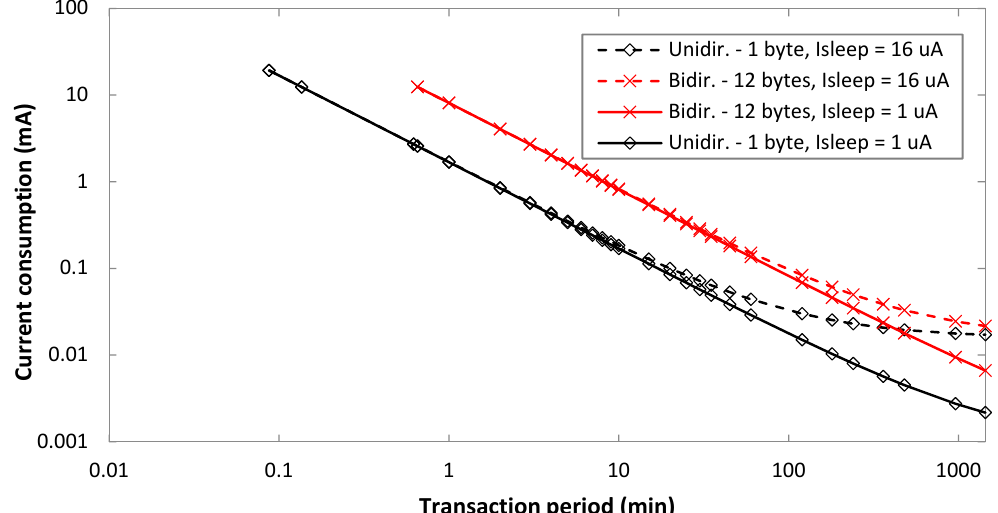
Figure 12. Average current consumption of the device, for different transaction types and uplink payload sizes, as a function of I sleep , for FLR = 0.